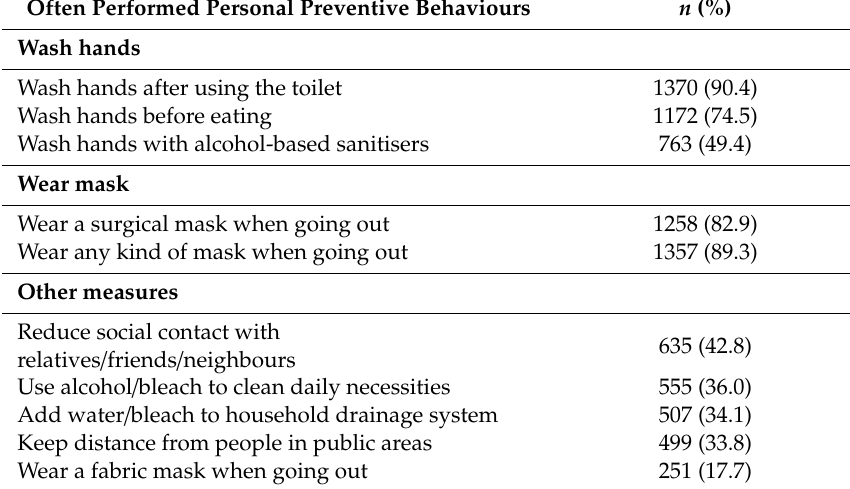
Table 2. The number and weighted percentage of often performed personal preventive behaviours against COVID-19 ( n =